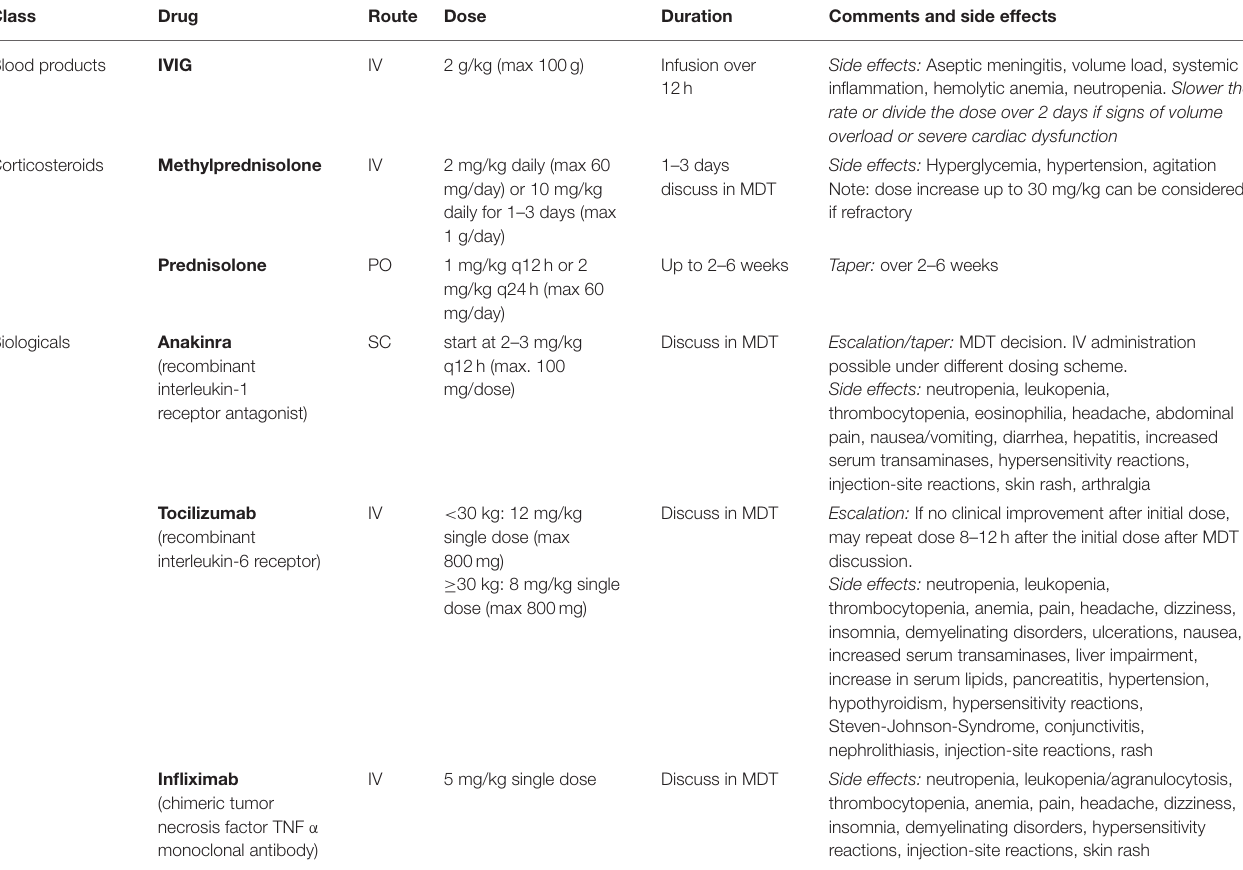
TABLE 3 | Anti-inflammatory therapies in patients with PIMS-TS.